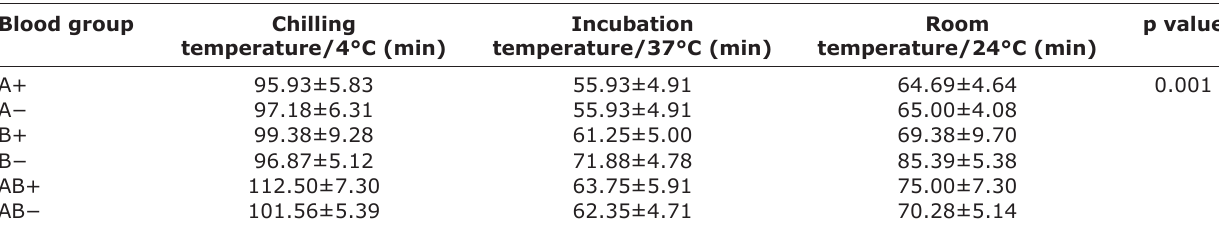
Table-5: Time required for HA of human RBC with NDV (lasota strain) within different temperatures (mean±SD). Blood